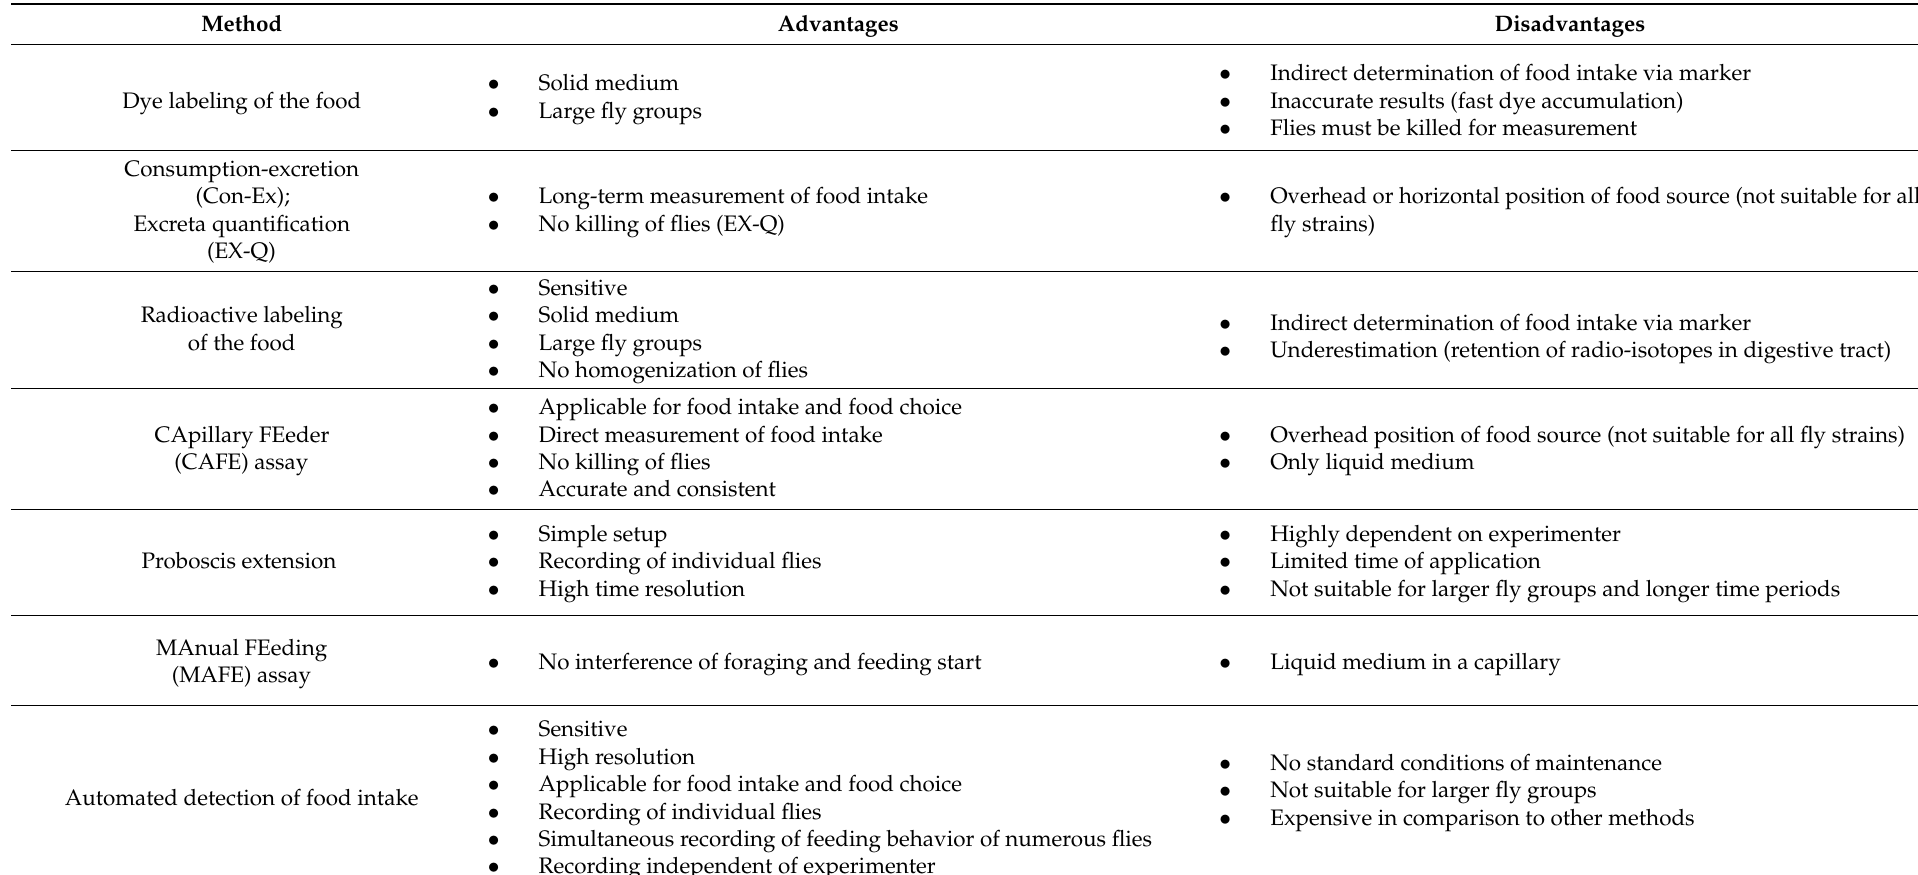
Table 2. Advantages and disadvantages of methods used for the determination of food intake and food choice in Drosophila melanogaster